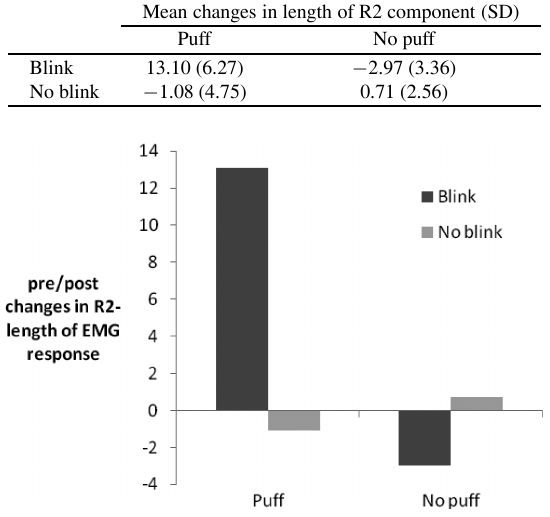
Fig. 4. Pretest to posttest changes in R2 length of corrugator EMG response to puffs. of the R2 component of the blink re fl ex tended to be increased, as re fl ected by a borderline signi fi cant Puff x Blink interaction, F (1,48) = 3.73, p = 0.06, η 2 p =